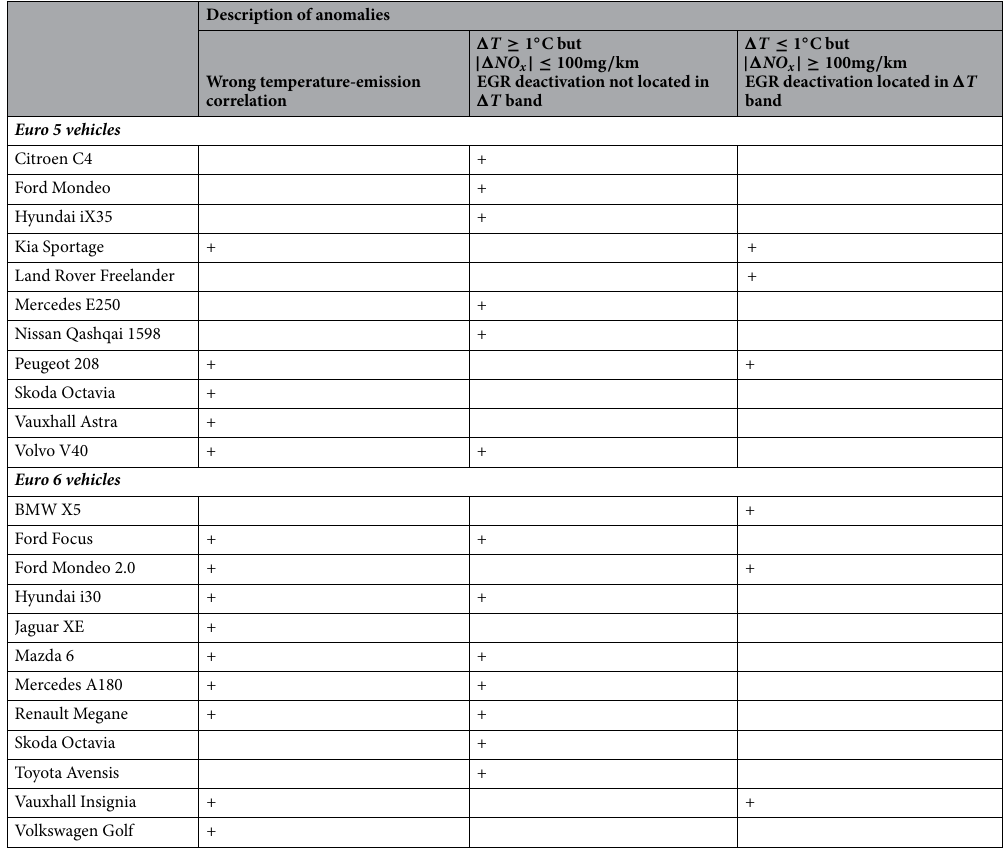
Table 1. Identification of vehicles exhibiting anomalies in the EGR temperature strategy. Cells with + represent positive display of the associated